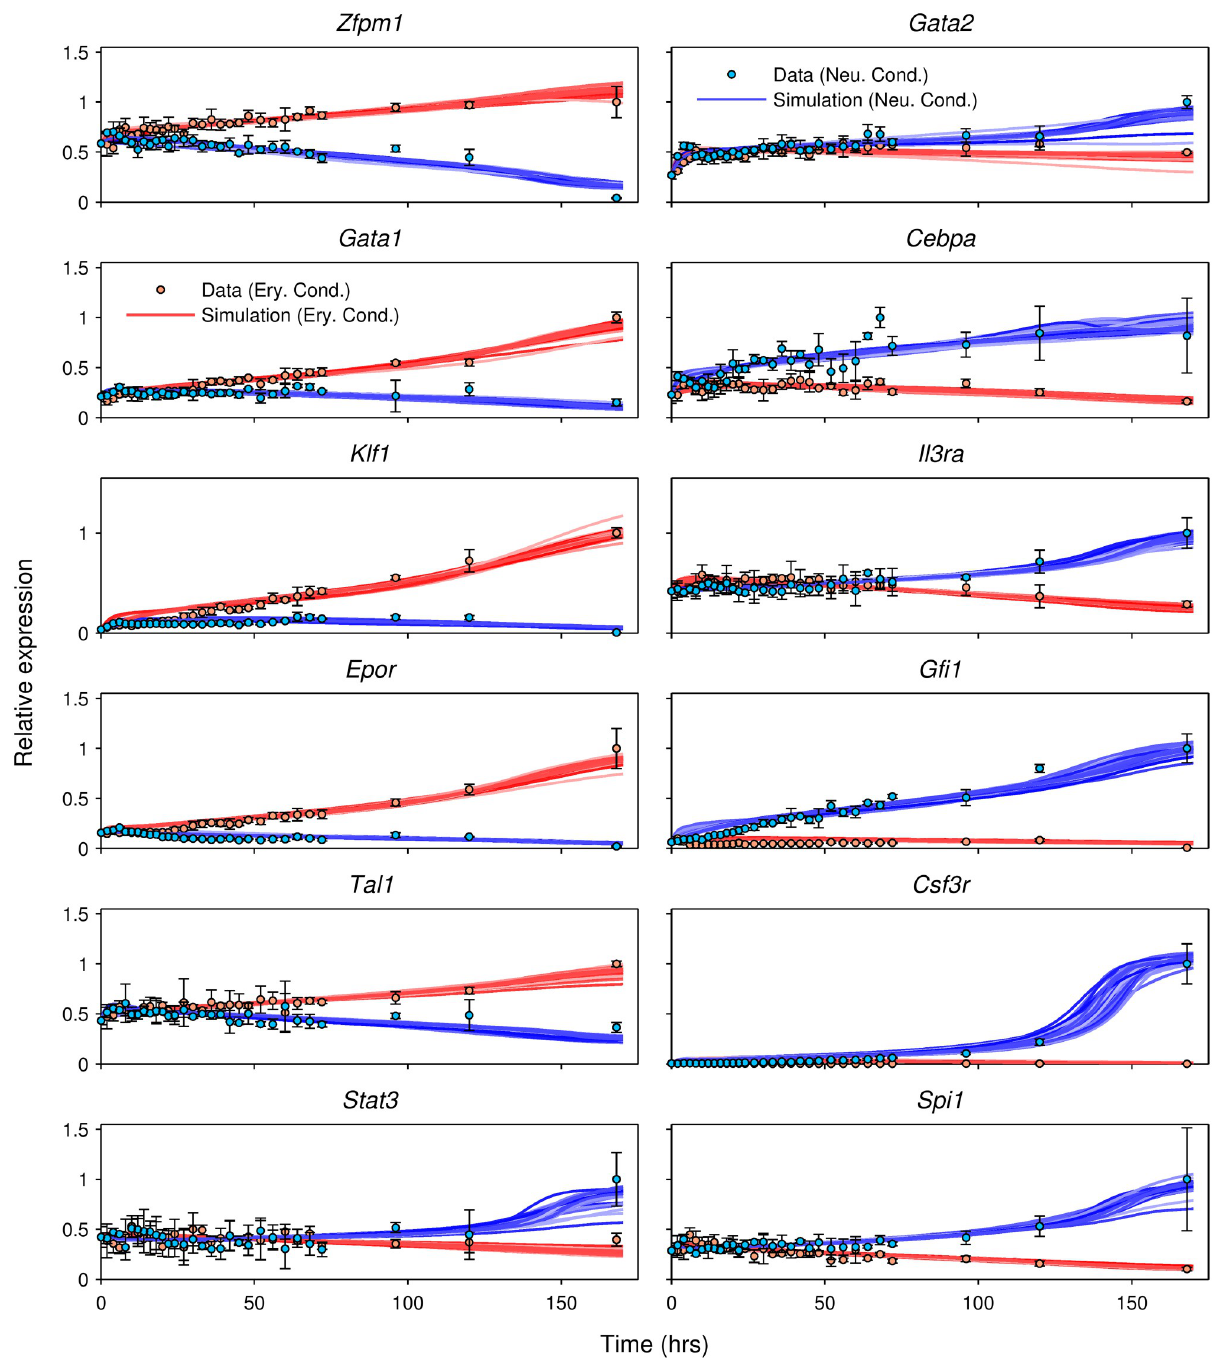
Fig 1. Gene expression time series data vs. model output. Mean microarray gene expression measurements and model output for the 12 modeled genes are plotted as circles and lines respectively. Here, and in the following figures, relative expression of a gene is given by the ratio of its expression to its maximum expression across all conditions and time points. Errors bars show standard deviation over 3 replicates. The output of the 71 models that met the goodness-of-fit criteria (Section 4) are shown simultaneously. Data and model output for FDCP-mix cells cultured in low IL3, Epo, and hemin, referred to as the erythrocyte condition hereafter, are shown in red. Data and model output for FDCP-mix cultured in GCSF and SCF, referred to as the neutrophil condition hereafter, are shown in blue.